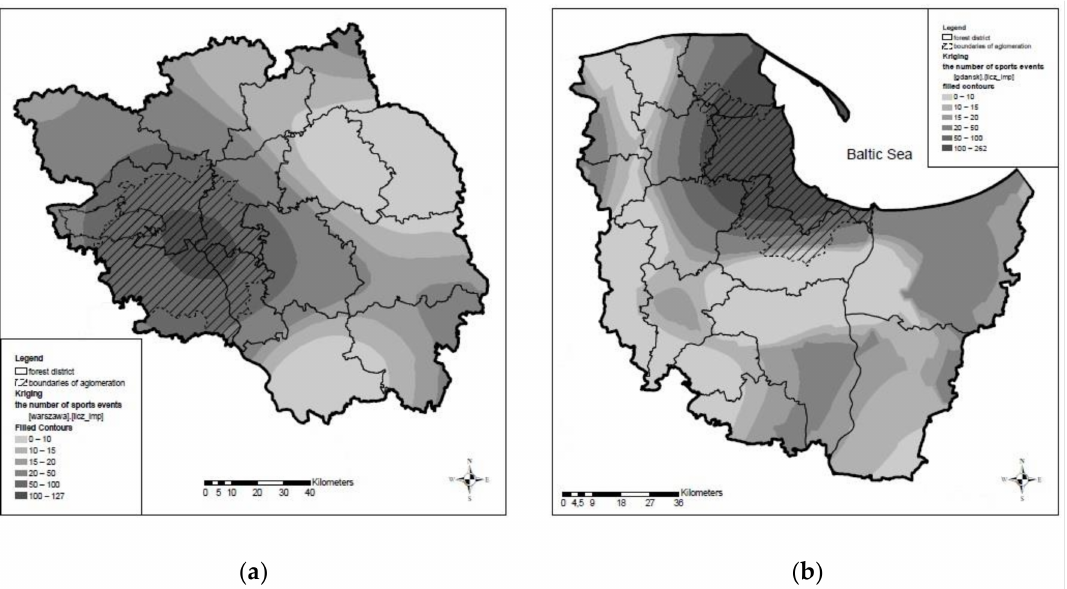
Figure 2. The spatial extent of organised forms of physical activity in forests of the urban agglomerations of ( a ) Warsaw and ( b ) Tricity.